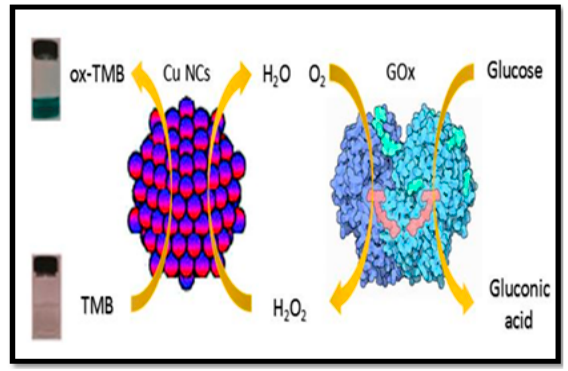
Figure 4. Colorimetric detection of glucose by using glucose oxidase (GOx) and a Cu NCs-catalyzed color reaction [91].